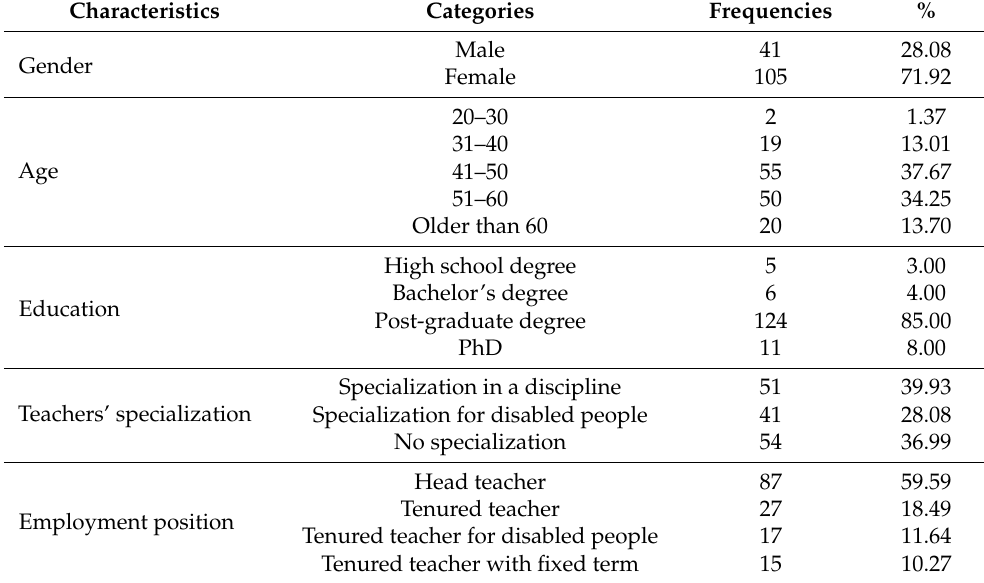
Table 1. Profiles of the